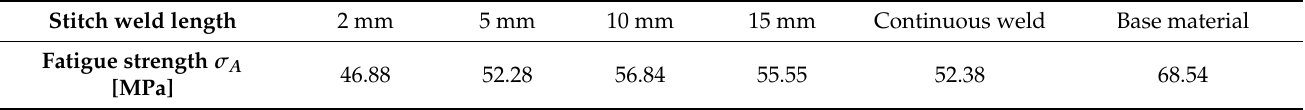
Figure 7. Experimental data of the fatigue tests and S-N lines for each stitch weld length, continuous weld and base material. Table 3. Fatigue strength at N = 2 × 10 6 cycles for all welded specimens and the base